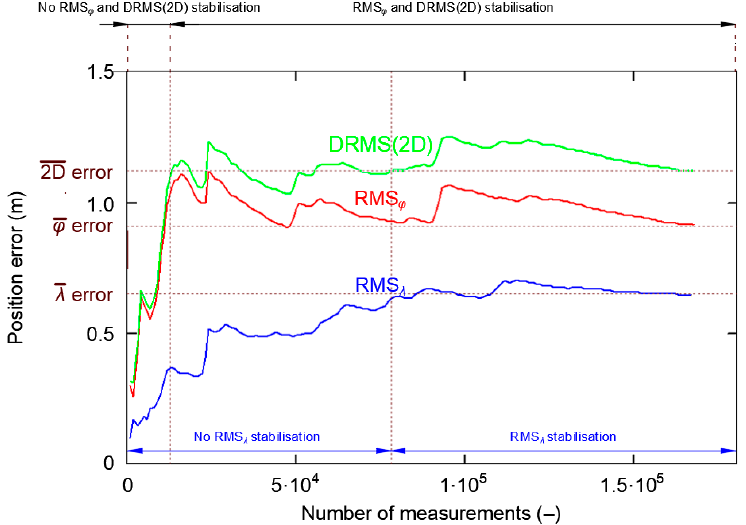
Figure 12. The process of stabilizing Root Mean Square (RMS) values for ϕ and λ , as well as Distance Root Mean Square (DRMS)(2D) for 168’000 fixes during the GPS measurement campaign in 2013. In order to verify the hypothesis on the existence of two periods (initial instability and stabilization) of the RMS error value, this phenomenon should be assessed against a di ff erent positioning result from a momentary decrease in the accuracy of the system’s position, which is caused by a